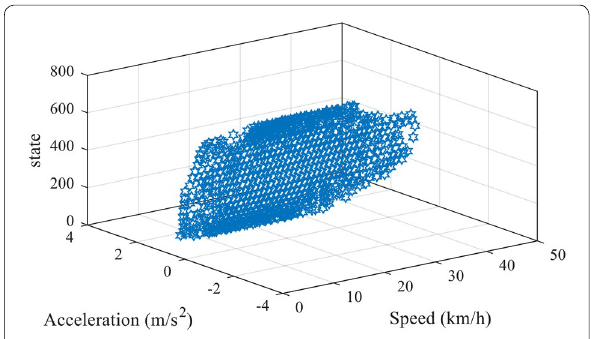
Figure 5 Vehicle speed status code